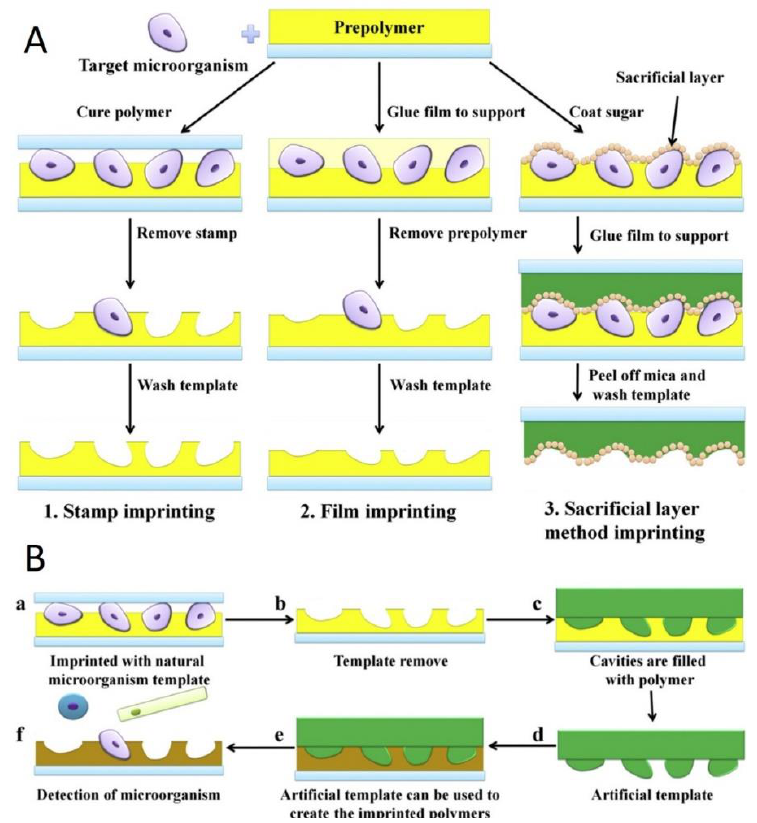
Figure 6. Schematic preparation procedures for three types of direct micro-contact imprinting ( A ) and indirect micro-contact imprinting ( B ). Reproduced from [26]—Published by Elsevier B.V.